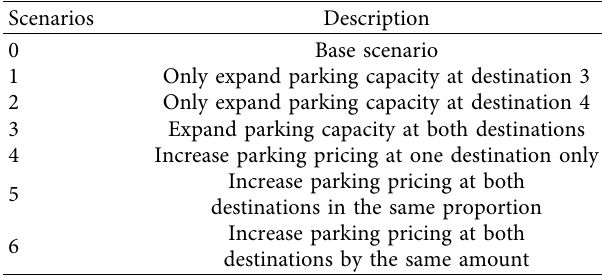
Table 6: Descriptions of